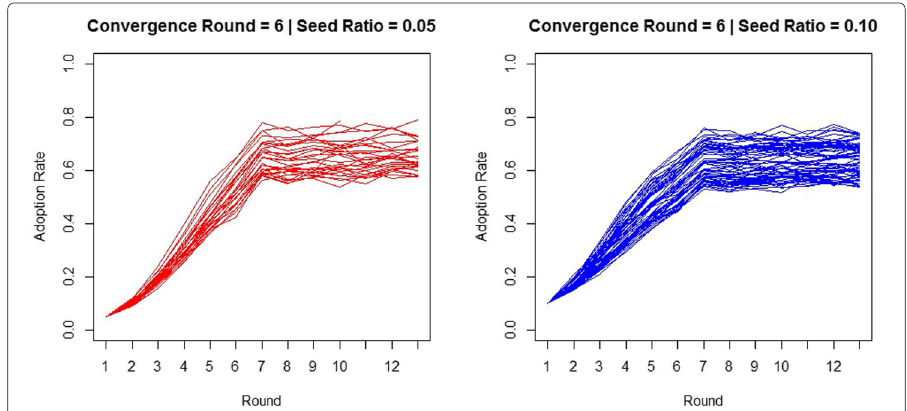
Fig. 7 Fluctuating diffusion curves (convergence round